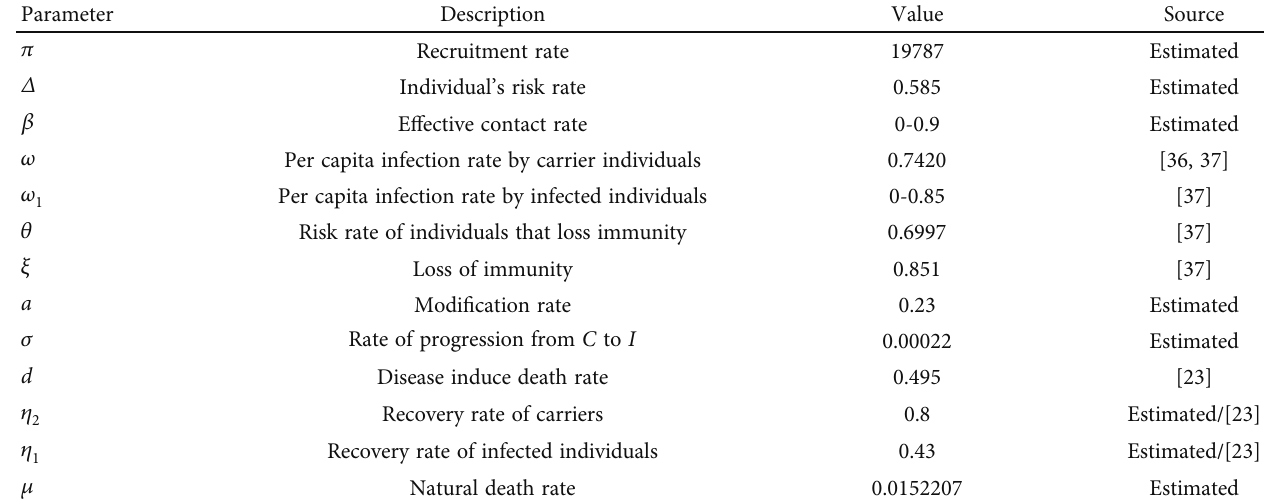
Table 4: Estimated parameter values of system (2) obtained from the curve fi tting process.